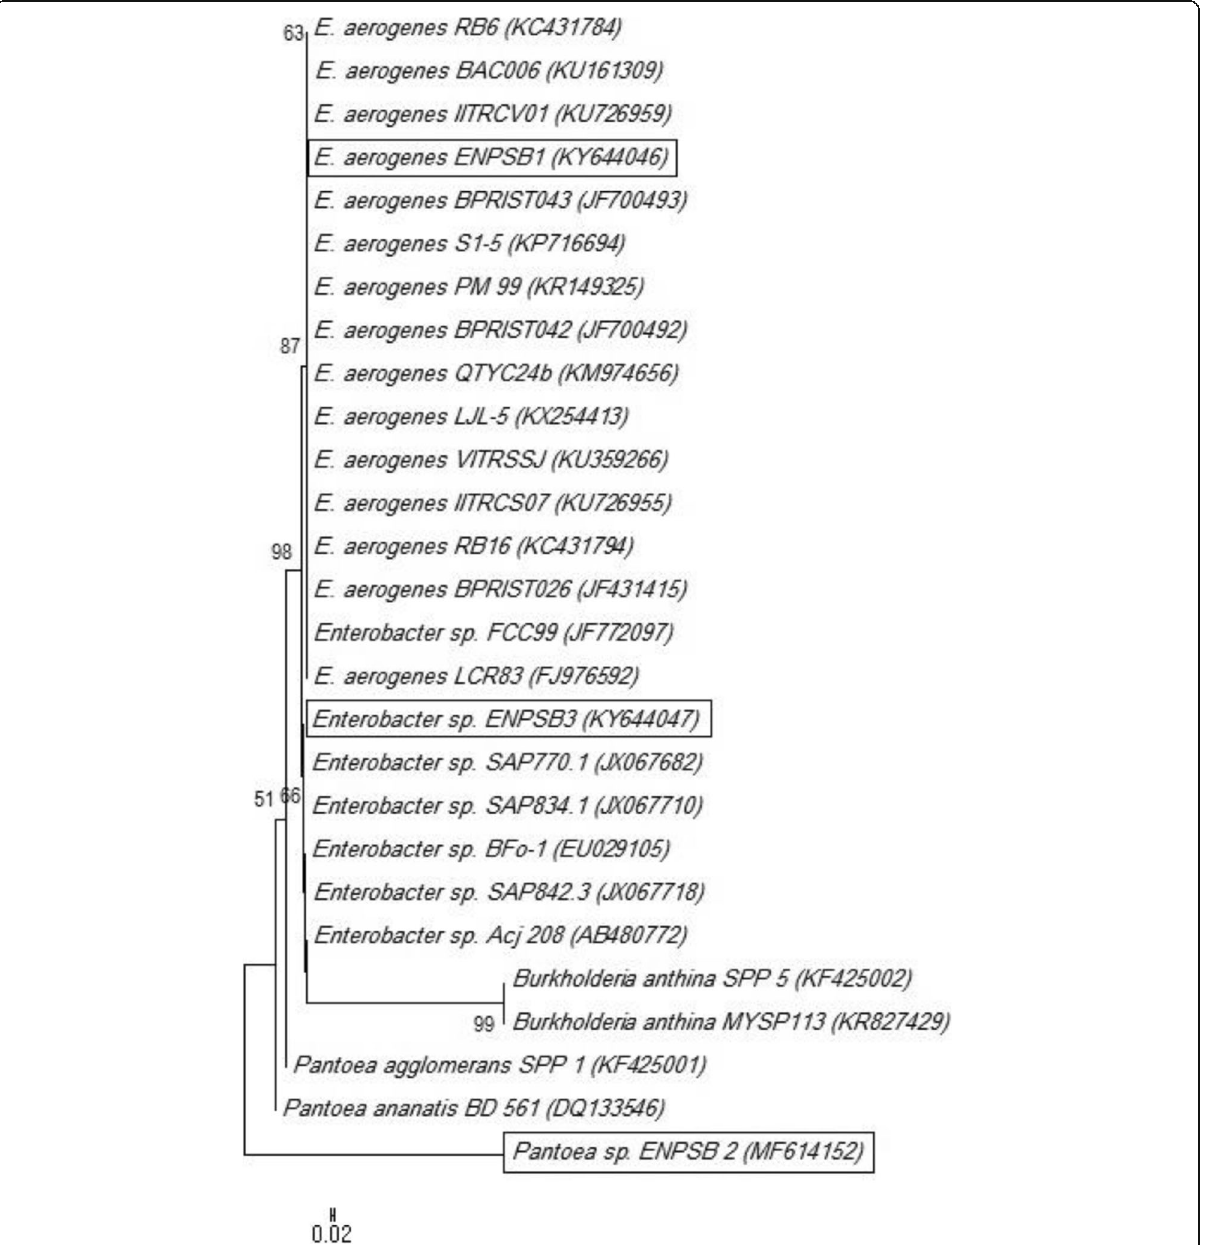
Fig. 4 Phylogenetic tree of three representative phosphate dissoloving bacterial strains and their genetic affiliation compared with standard strains based on partial 16S rRNA sequence analysis (the Egyptian native strains are put inside the